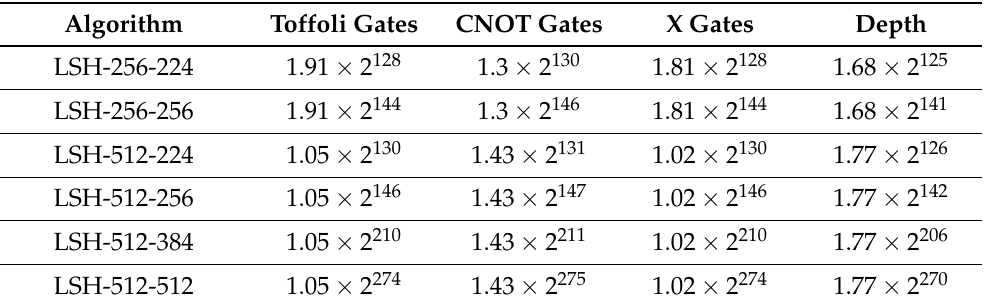
Table 7. Quantum resource estimation result required for Grover’s algorithm of parallel LSH quan- tum